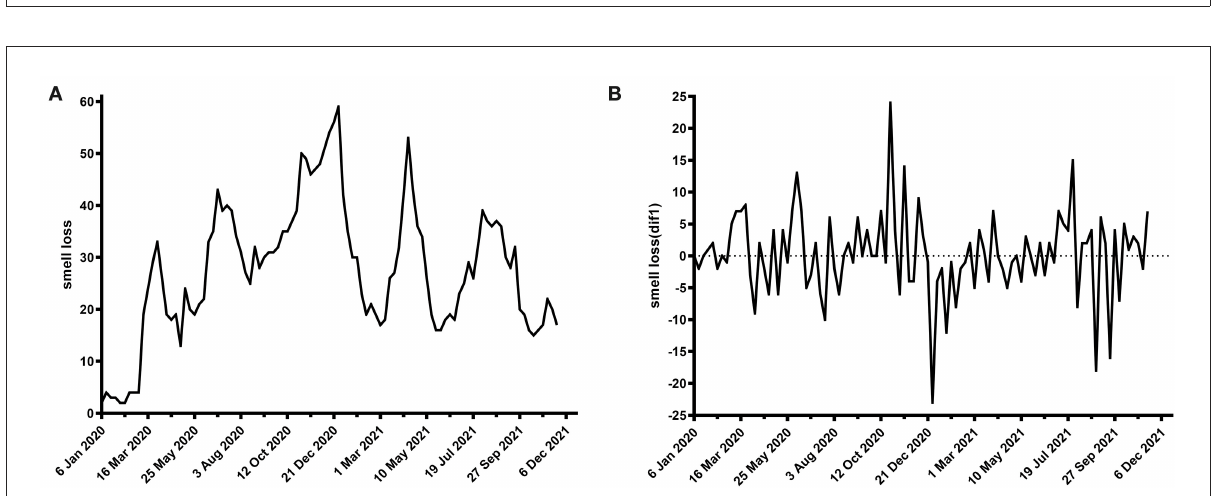
FIGURE2 Time plot of Google Trends for smell loss per week worldwide. (A) Raw data, (B) first-order difference.